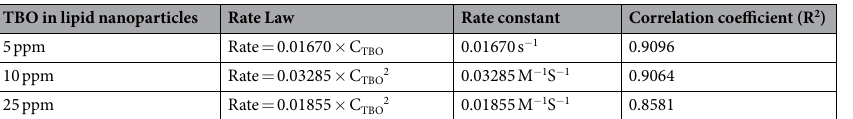
Table 3. Kinetics governing the generation of singlet oxygen from TBO in lipid nanoparticles * . * C TBO : Concentration of